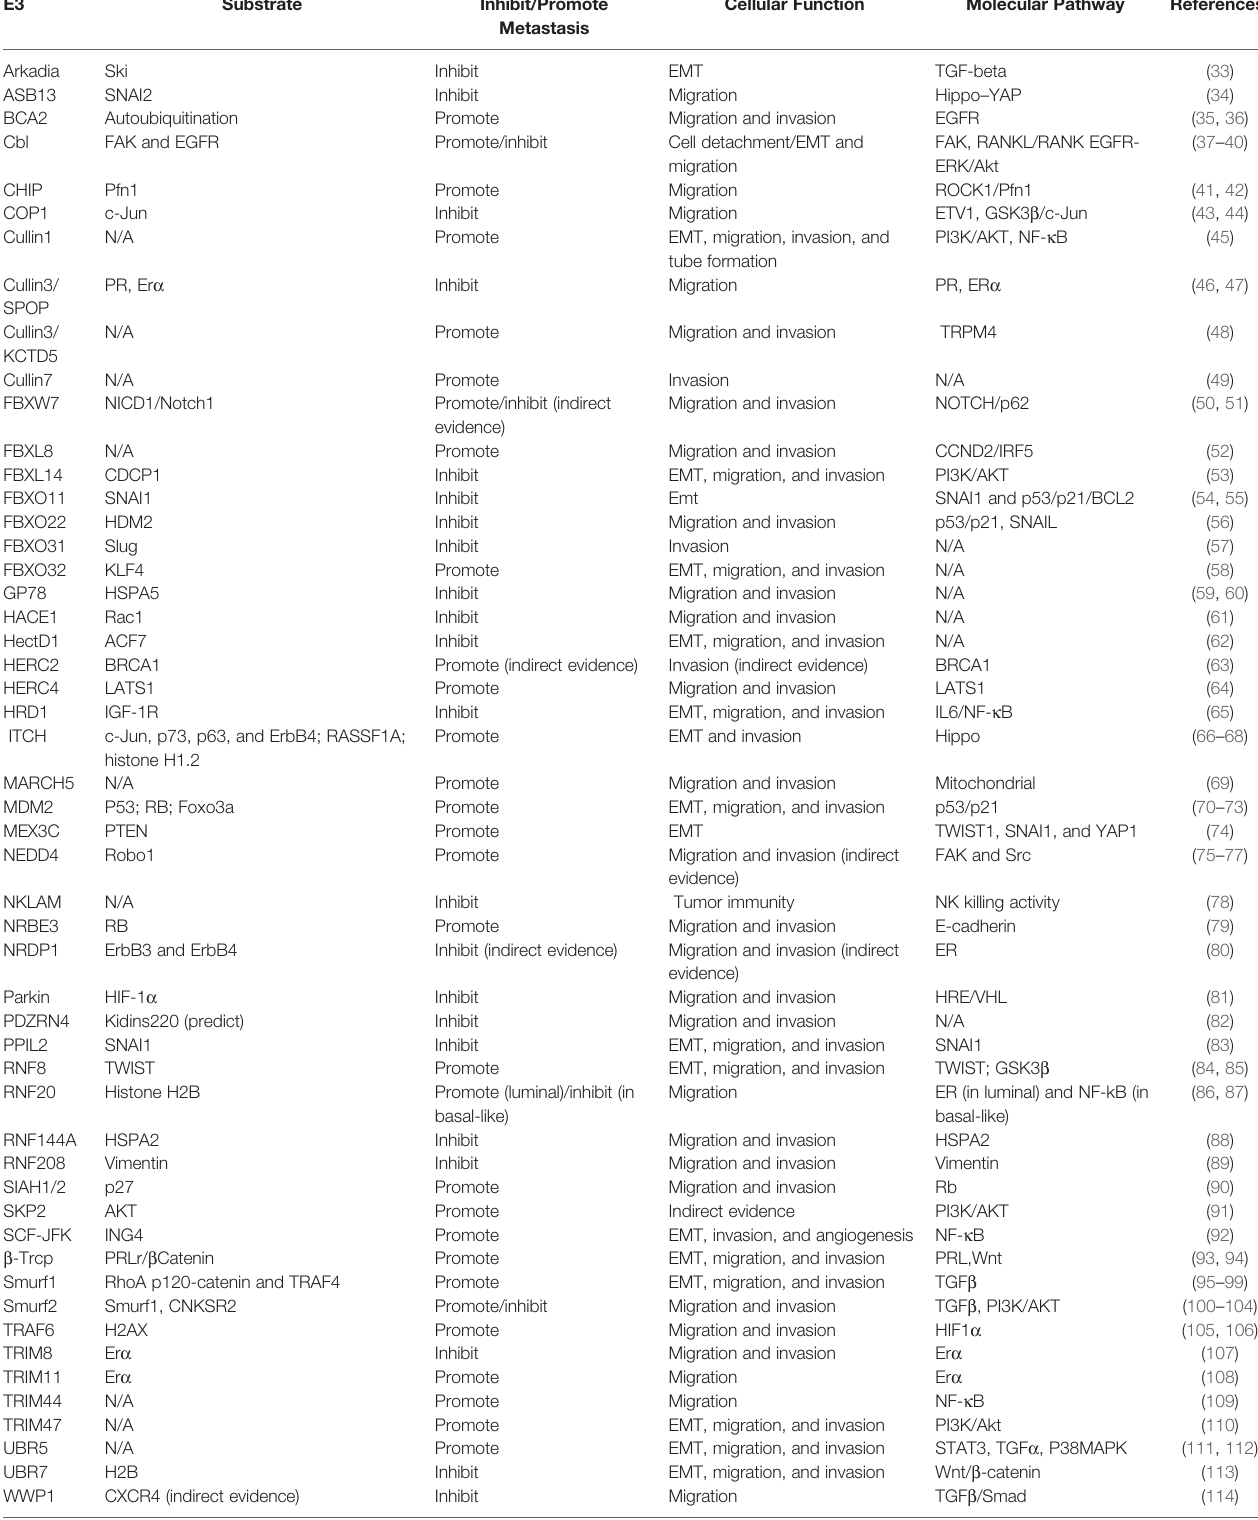
TABLE 1 | E3 ubiquitin ligases that played important roles in the multiple steps of breast cancer metastasis